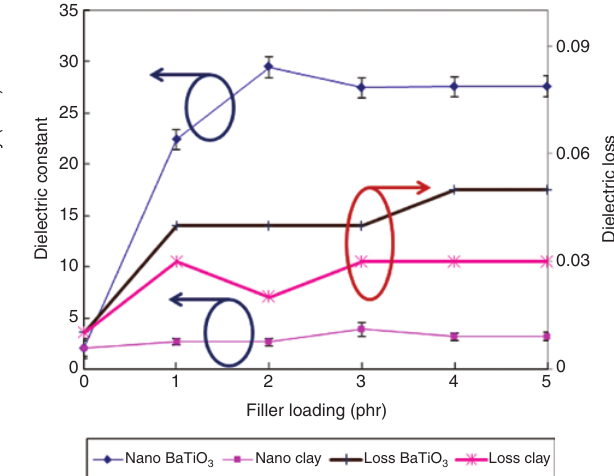
Figure 6: Dielectric constant and dielectric loss at 1 MHz as a func- tion of filler